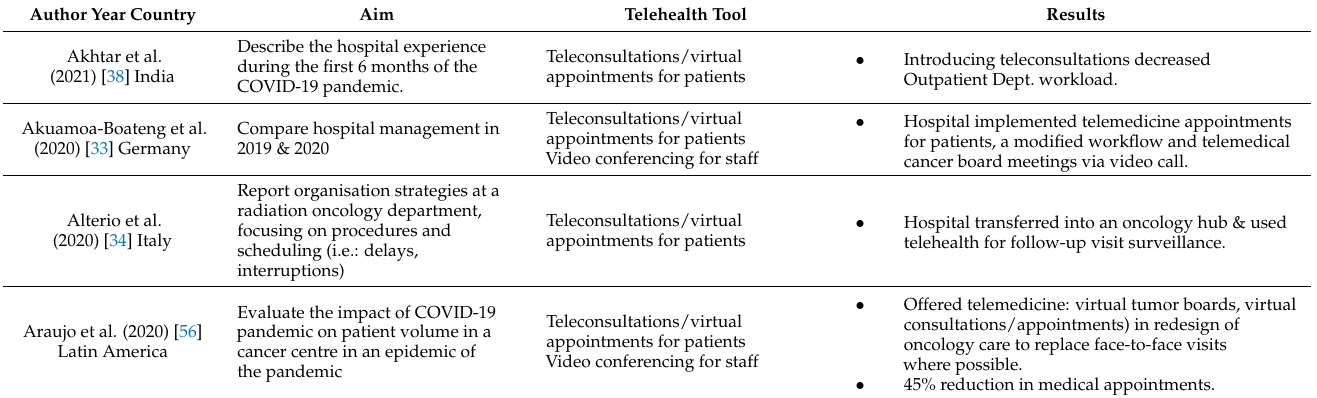
Table 2. Overview of Review Papers (See Appendix C for further